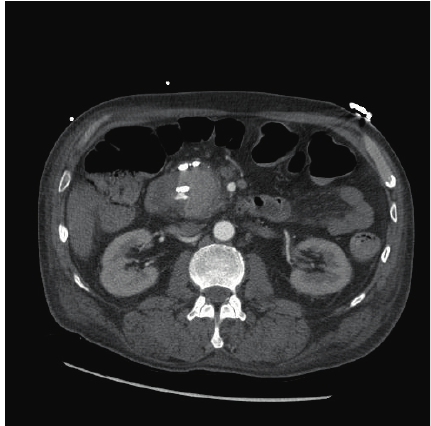
Figure 2: Computer tomography without measurements of pseudoaneurysm.